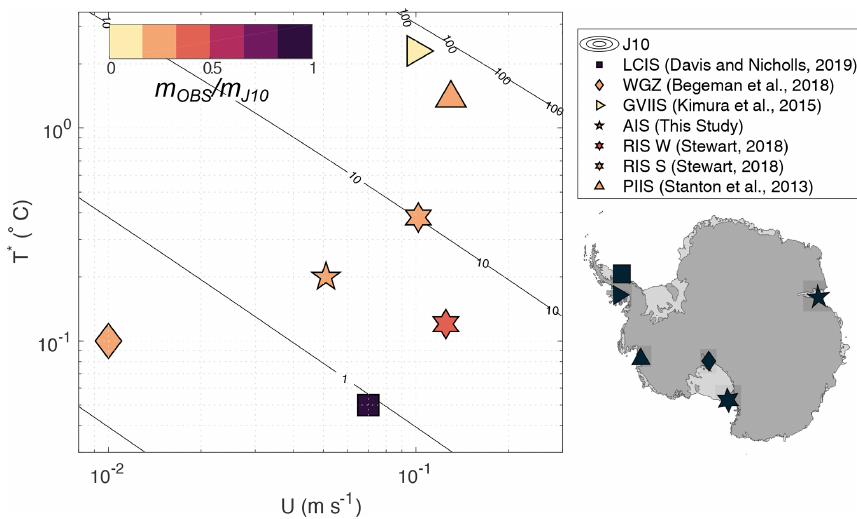
Figure 10. Ratio of observed ( m OBS ) to predicted melt rate for the J10 parameterisation ( m J10 ) as a function of thermal driving ( T ∗ ) and free stream velocity ( U ) for published ice shelf datasets. Contours show m J10 . Map shows the location of the